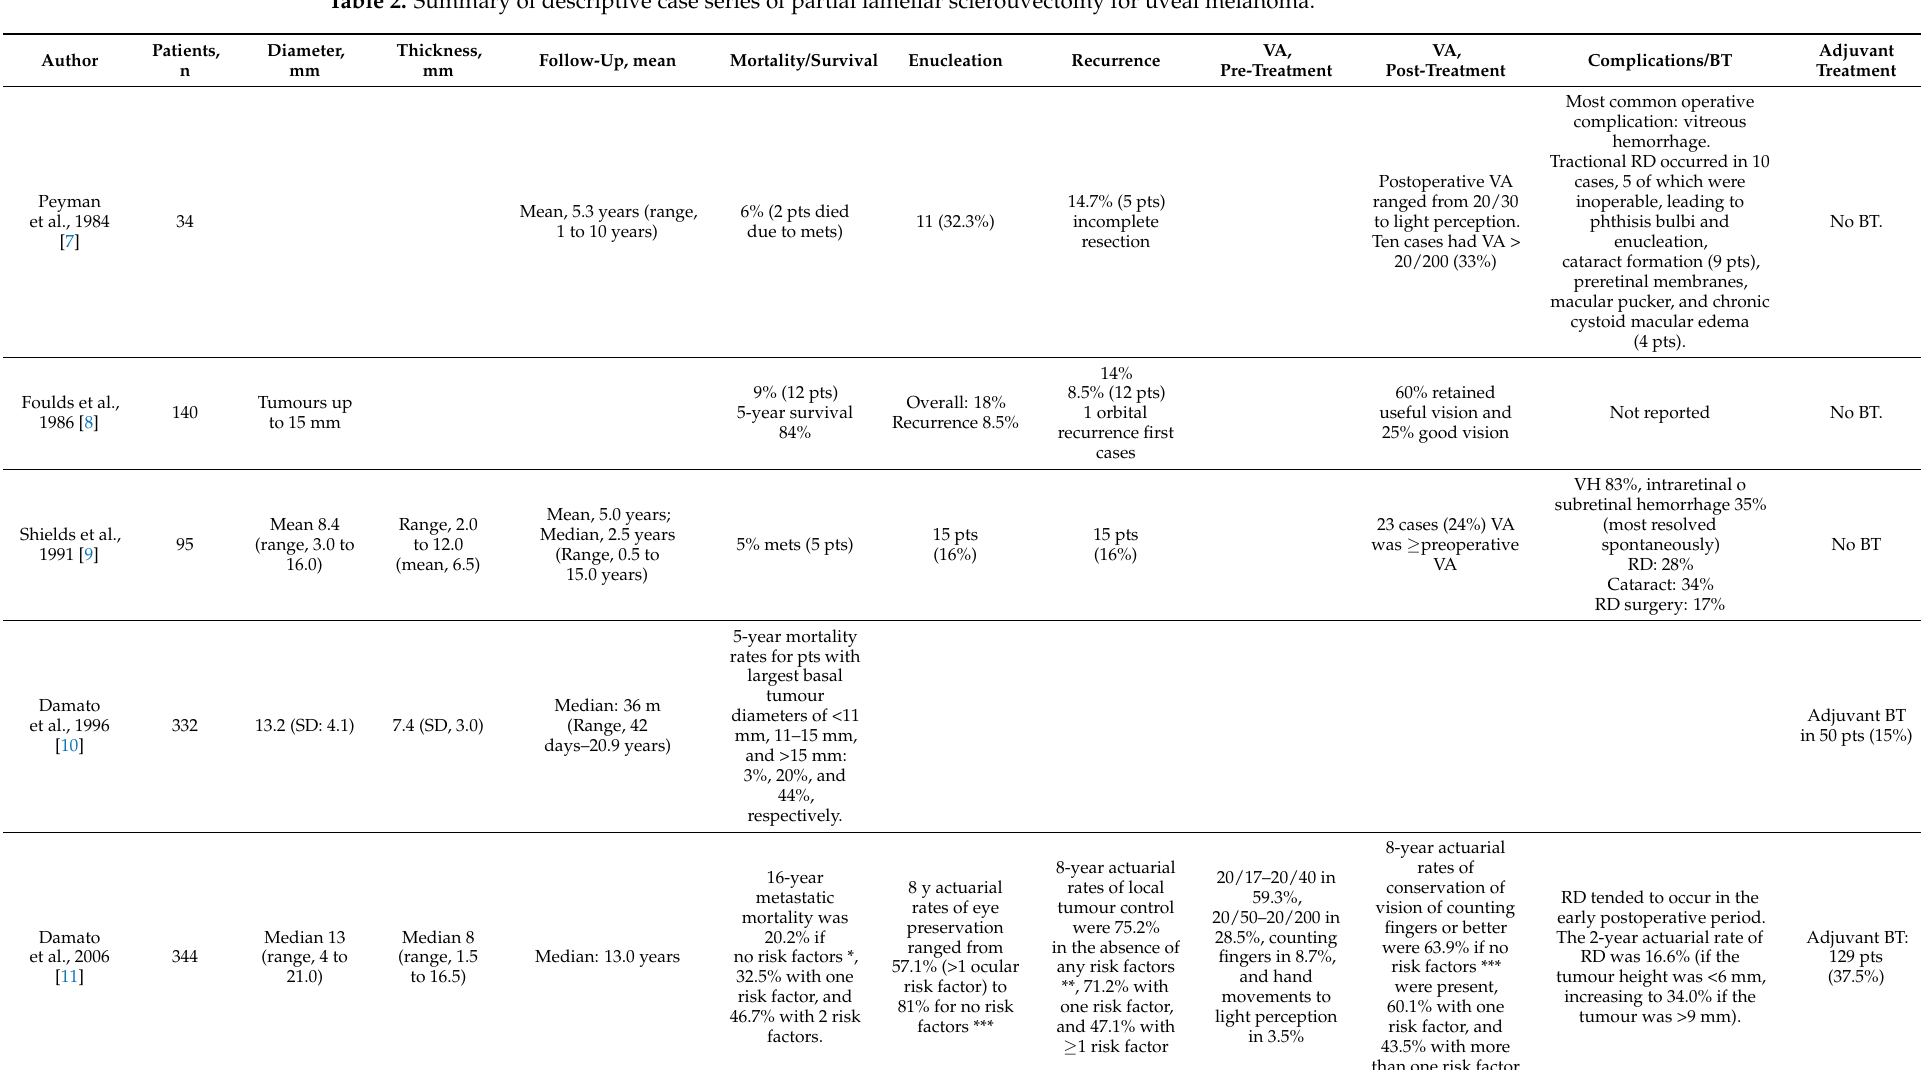
Table 2. Summary of descriptive case series of partial lamellar sclerouvectomy for uveal